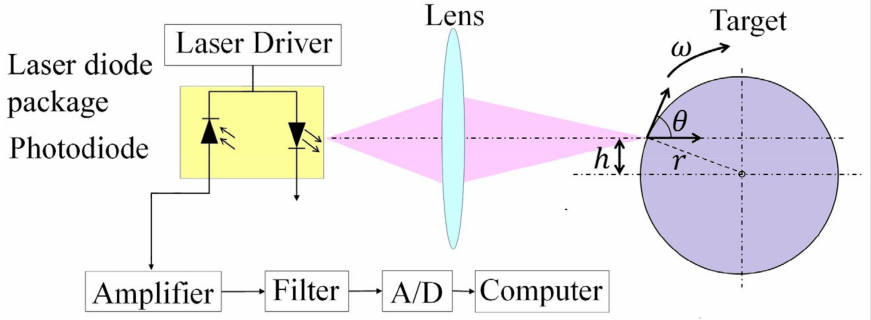
Figure 11. Schematic structure of SMI rotational speed measurement [7] (Reprinted with permission from [18] © The Optical